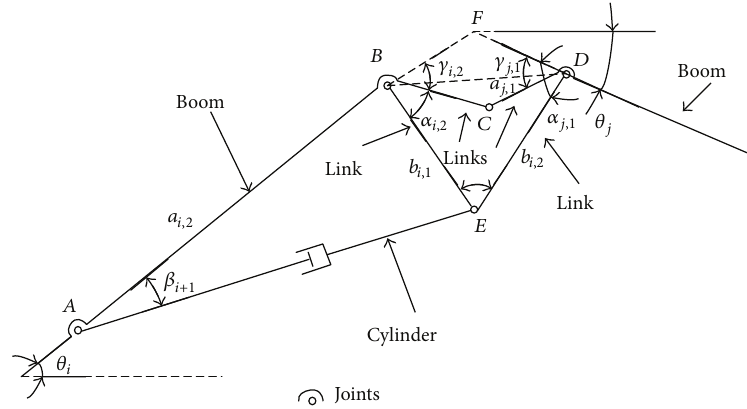
Figure 3: Connection relationship of the other three booms, links, and hydraulic cylinders.